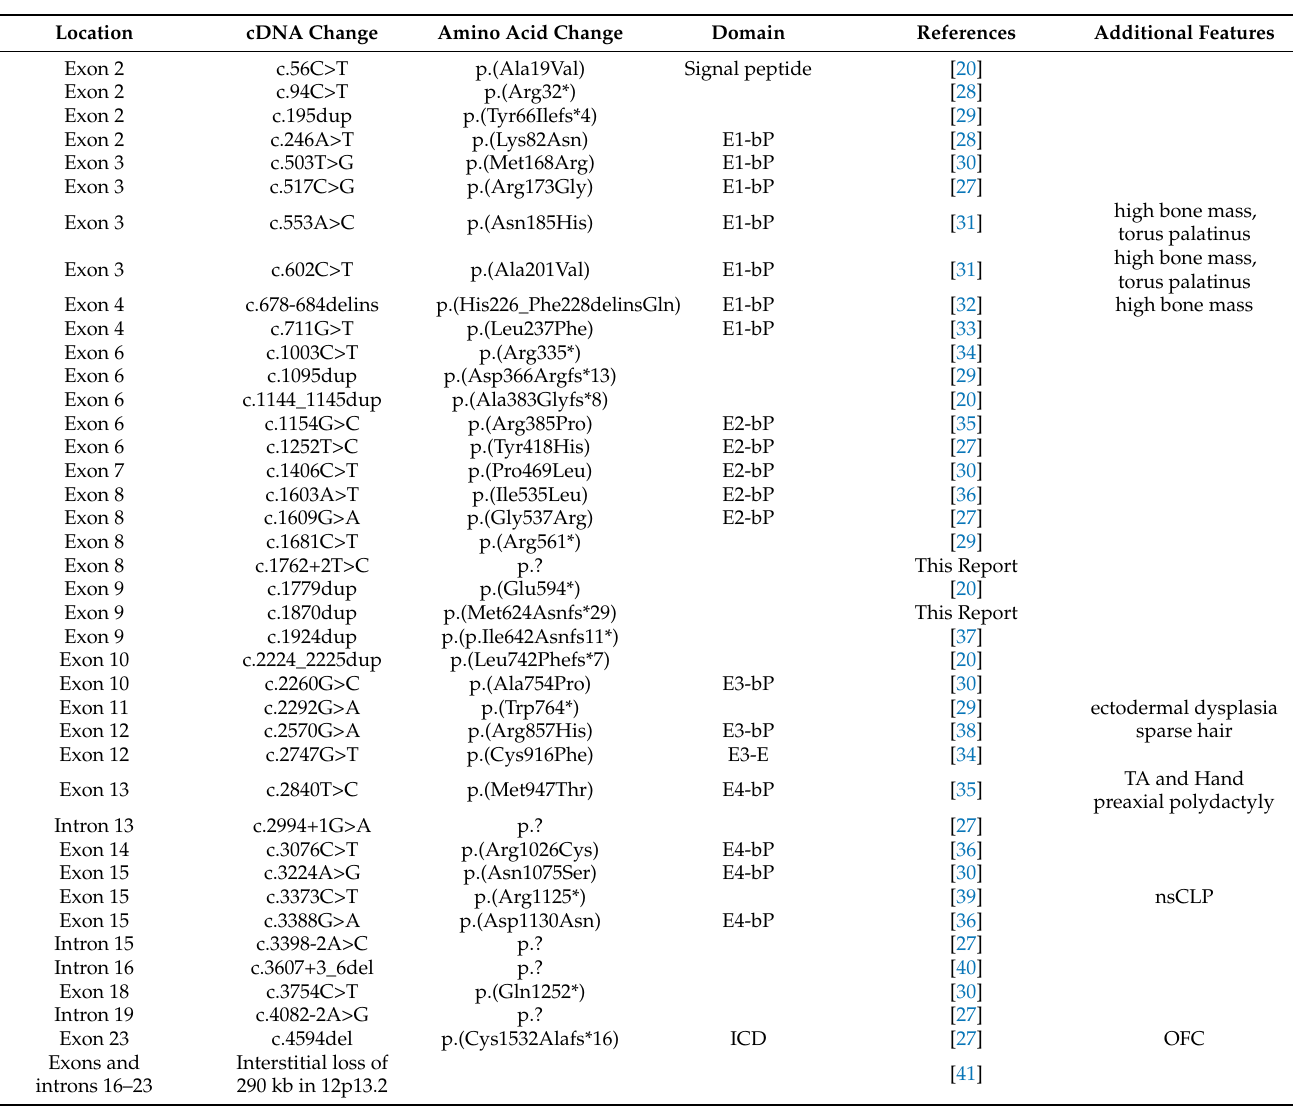
Table 2. LRP6 mutations related to tooth